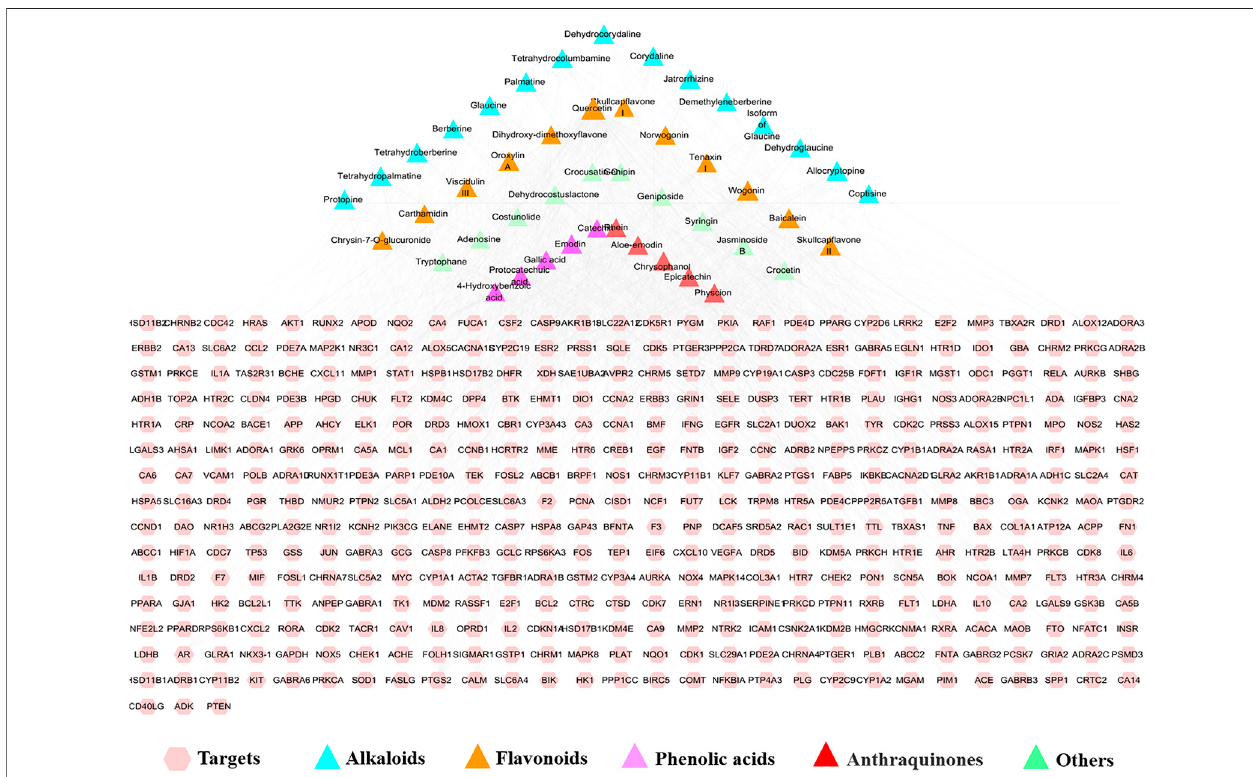
FIGURE 3 | Compound-target network of QYD (Pink circle represents target; Triangle represents compound in QYD. It ’ s a positive proportional relationship that between the node size and the degree).